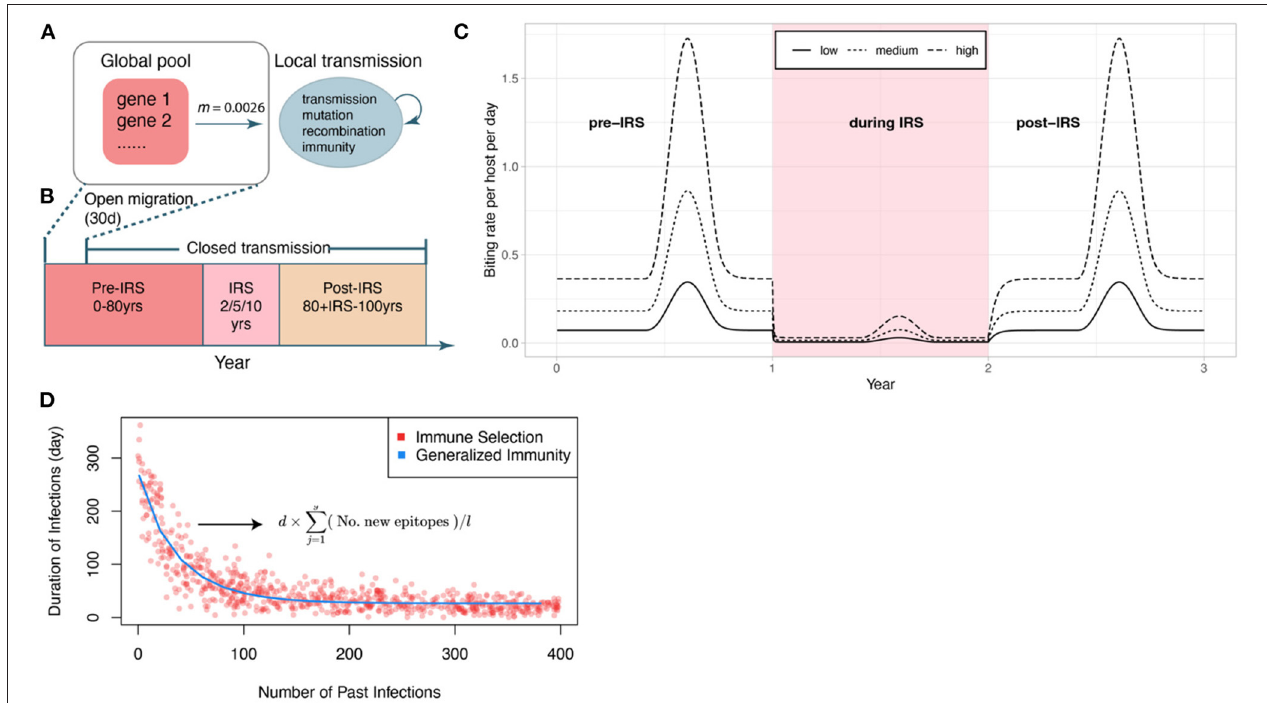
FIGURE 1 | Schematic of the IRS experiment design. (A) Initial transmission events and migrant genomes in a local population (blue circle) are sourced from a global pool of genes (red square) (see Methods). The value of the migration rate is inferred from an empirical dataset for a high transmission region in Ghana (see Methods). Individual infections are tracked locally. We also track events of transmission, mutation of genes, recombination within and between genomes, and acquisition and loss of specific immune memory in hosts. (B) The period of open migration from the global pool lasts for 30 days to initialize the system. Each simulation follows three stages (after a burn-in period): a pre-IRS period during which the transmission in the local population reaches a stable state; an IRS period of 2, 5, or 10 years reducing transmission, and a post-IRS period when transmission rates go back to pre-IRS levels. (C) Three levels of transmission intensity (biting rates) are explored in the experiments (pre-/post-IRS, low: 44 bites per host per year; medium: 110 bites/h/y; high: 221 bites/h/y). (D) The two regimes (with and without NFDS) are ensured to be comparable by specifying the average duration of infection as a function of the number of previous infections in G with a curve fitted to the points generated under S. The expression for the duration of infection under S is given here, and its explanation can be found in the methods